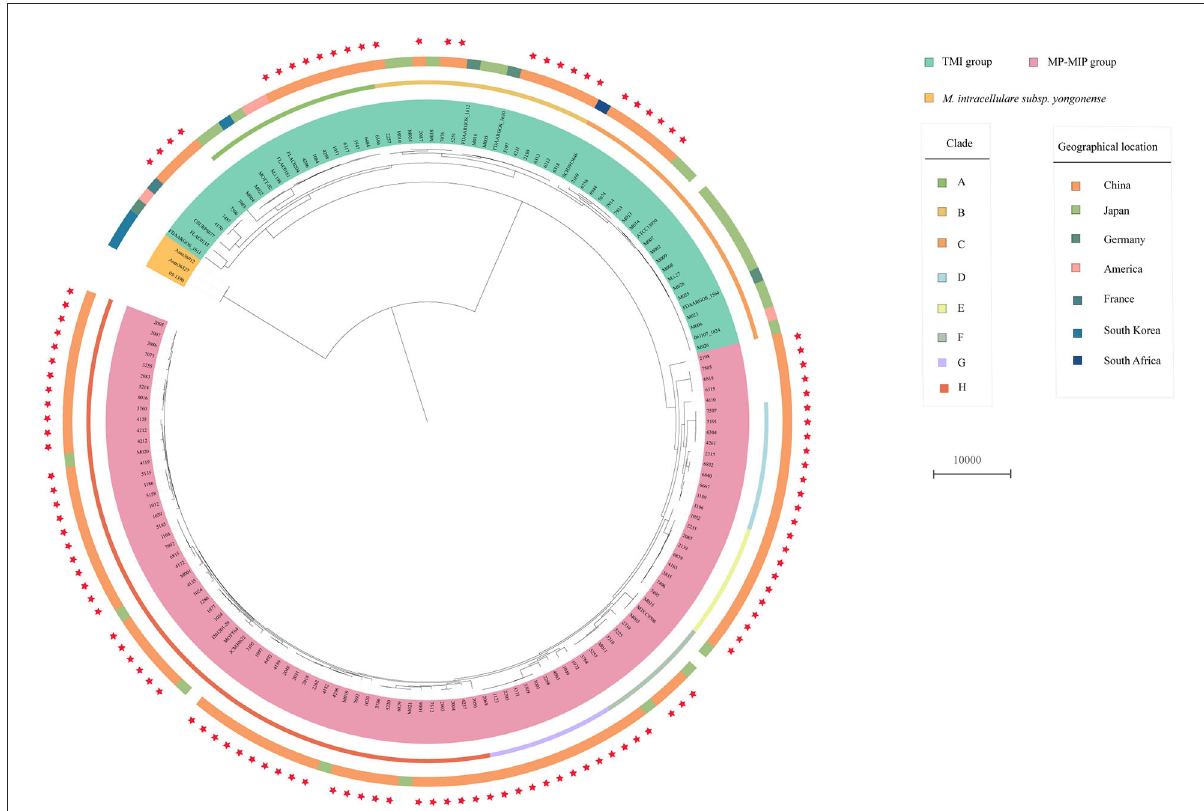
FIGURE1 Phylogenetic tree of the 117 clinical M. intracellulare strains in this study, 30 M. intracellulare strains, and 14 related strains from the NCBI genome database. The tree based on core SNPs was constructed by RAxML with GTR + G model, with 1000 bootstrap replicates. The group type, clade, and geographic location of the strains are shown on the tree (from inner to outer circles), according to the color legend shown on the right. The red stars on the outside represent the strains in this study.